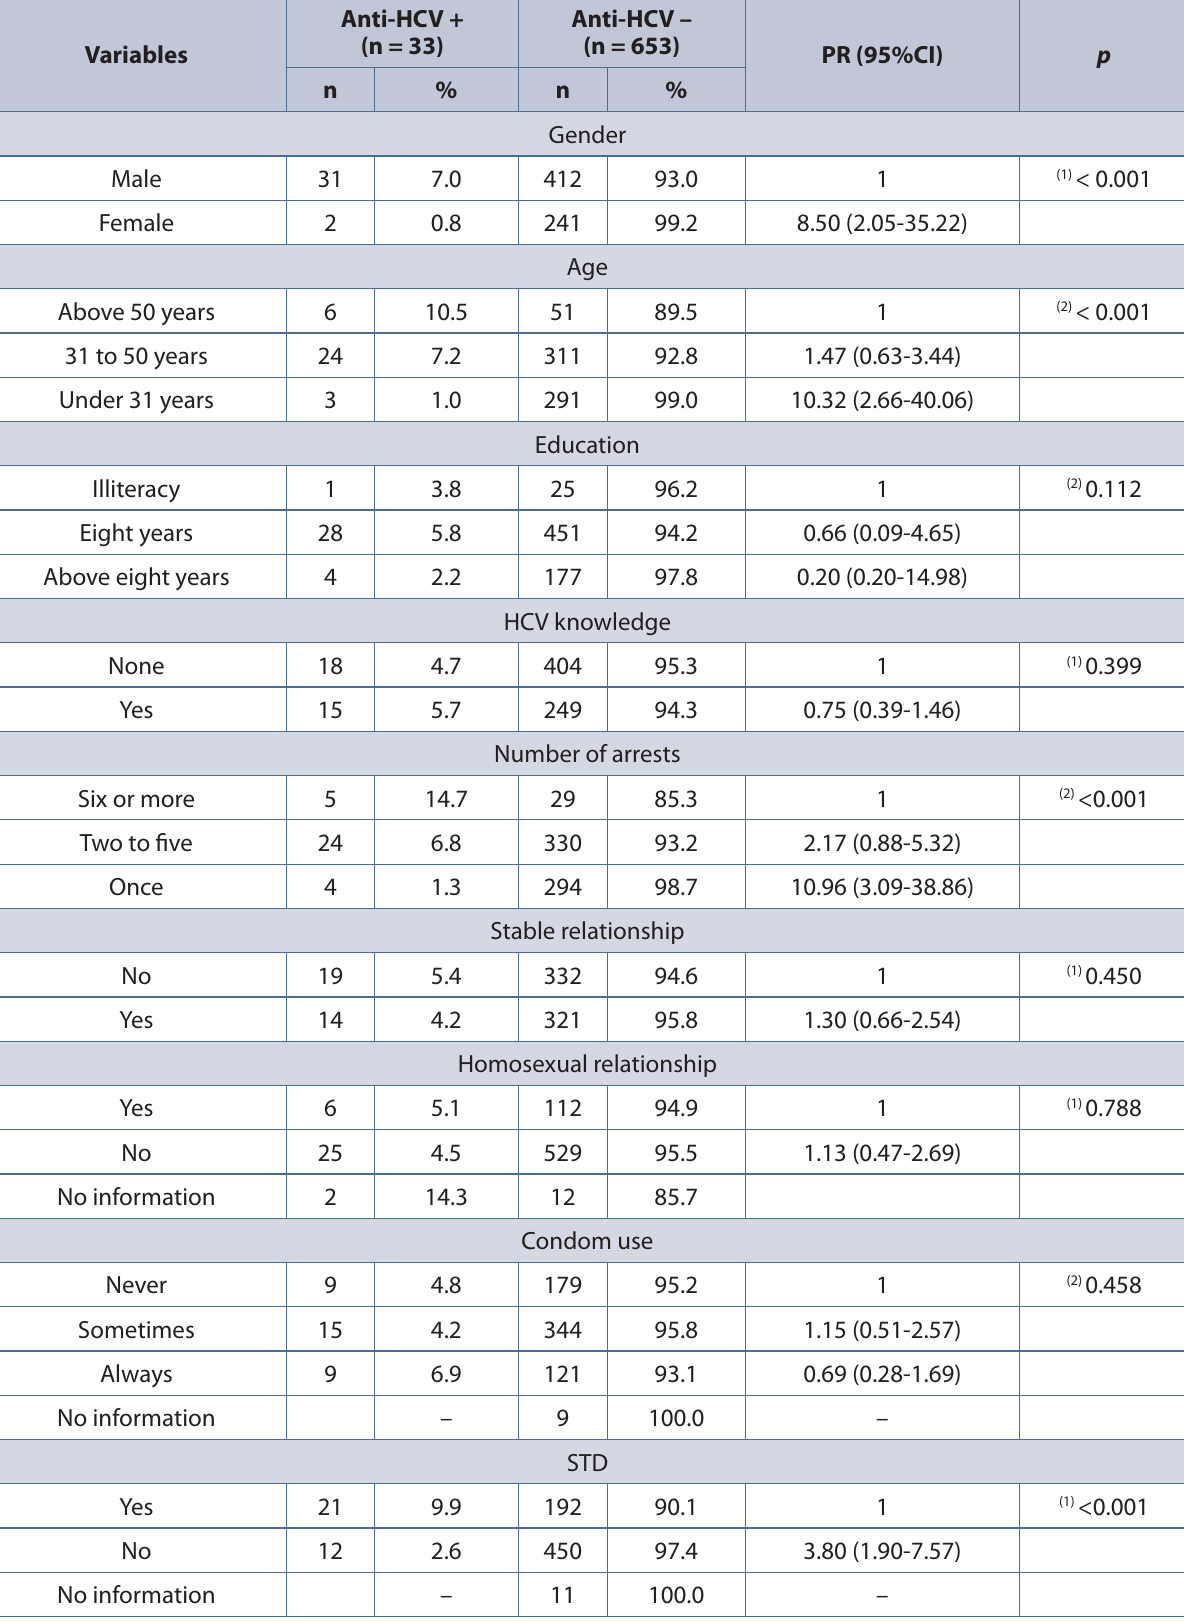
Table 1. Distribution of data from prisoners according to factors associated with HCV infection in Campo Grande, Mato Grosso do Sul, Brazil in 2010 (n = 686)